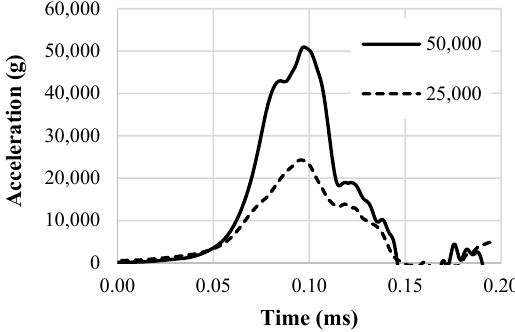
Figure A2. Acceleration curves from high g testing.